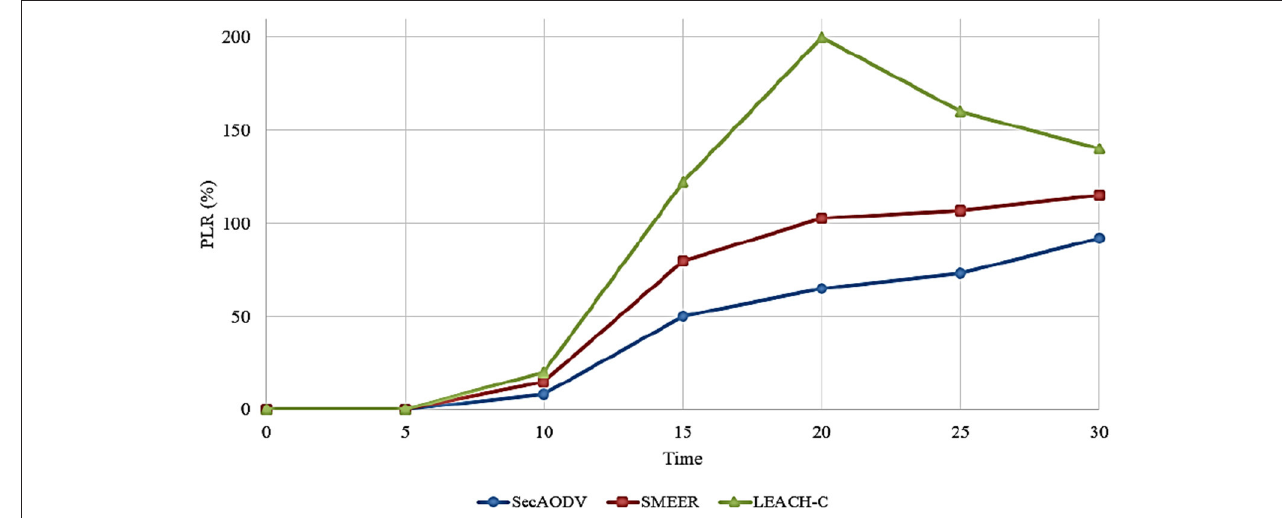
FIGURE 10 | Comparison of different methods in terms of PLR.